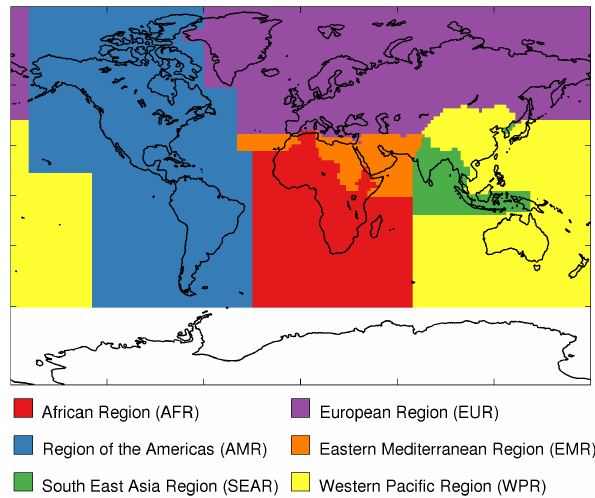
Fig. 2. Definition of the WHO regions based on a list of countries in each region (WHO, 2012) and gridded data set of the world’s countries (Lerner et al.,